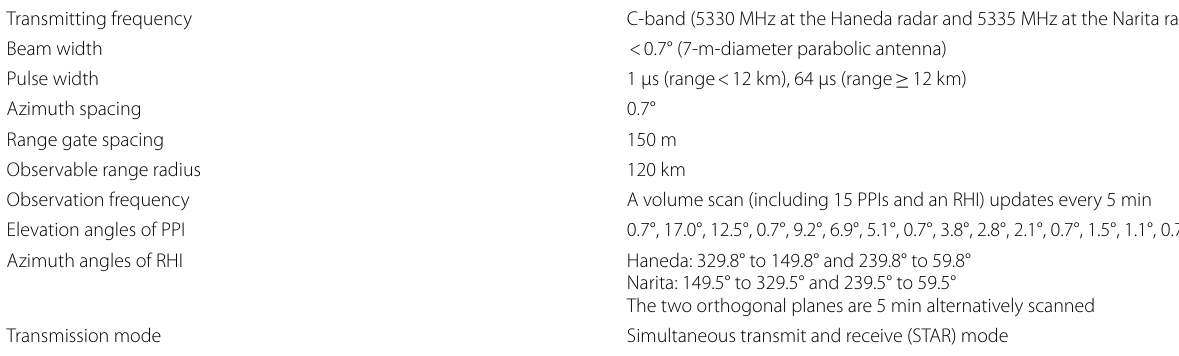
Table 1 Basic specifications of the Haneda and Narita radars (Tsukamoto et al. 2016; Umehara et al.